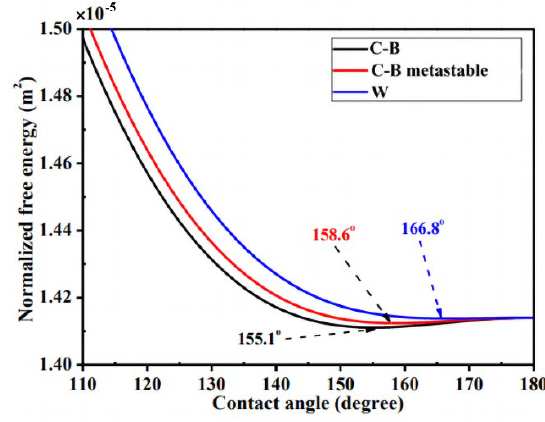
Figure 6. Schematic illustration for the variations in normalized free energy with apparent contact angle for C–B, C–B metastable, and W states on multi-scaled microstructure. Reprinted with permission from Ref. [102]. Copyright@2017, Physicochemical and Engineering.